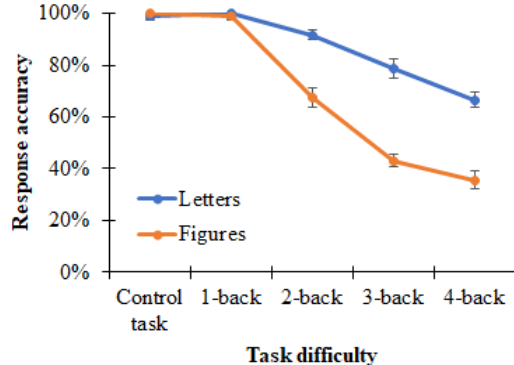
Figure 3. Means and standard errors for performance (i.e. response accuracy) as a function of task difficulty (mental load) and stimulus type (visual load). Data of the respective two levels of mental load (e.g. the two 1-back trials with letter stimuli) were pooled.